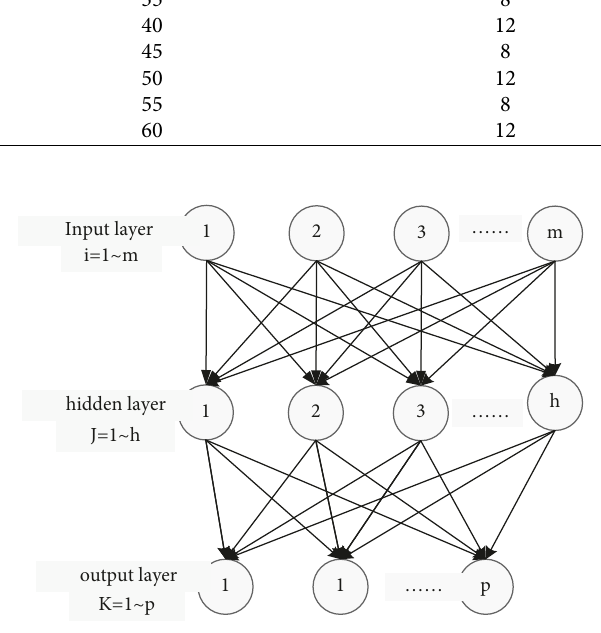
Figure 1: The structure of Table 1. The mixture of all adulterated samples is evenly